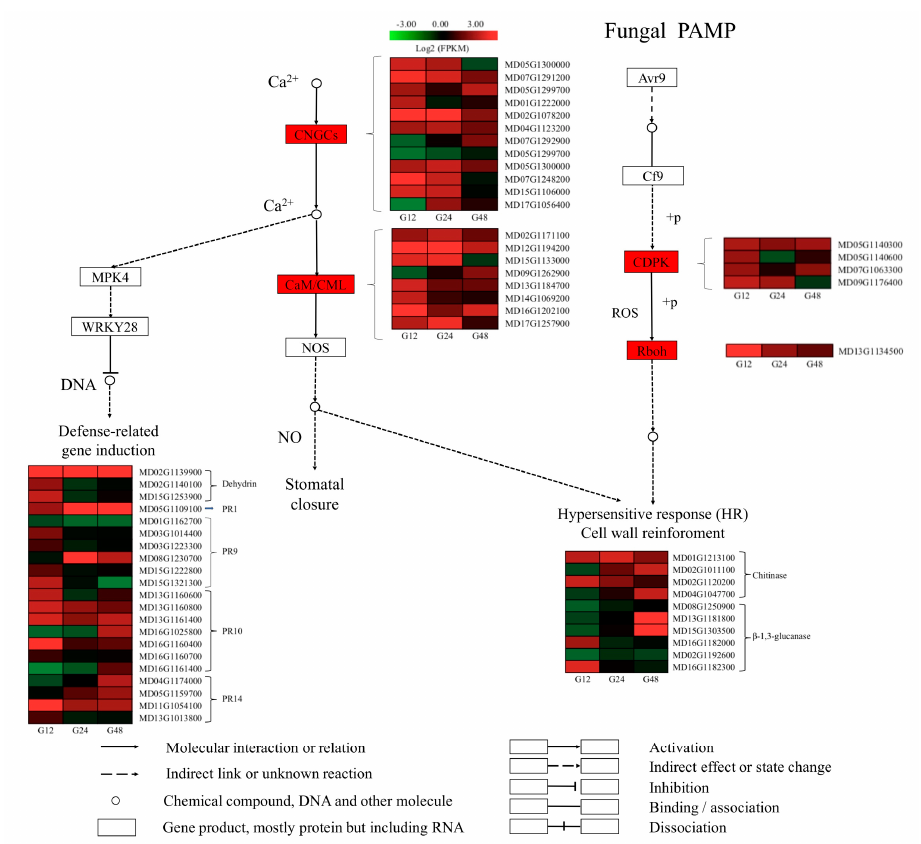
Figure 3. DEGs involved in plant-fungal interaction. Expression values are presented as log 2 FPKM value (red for upregulated, green for downregulated), and the vertical columns represent 12, 24 and 48 hpi from left to right.